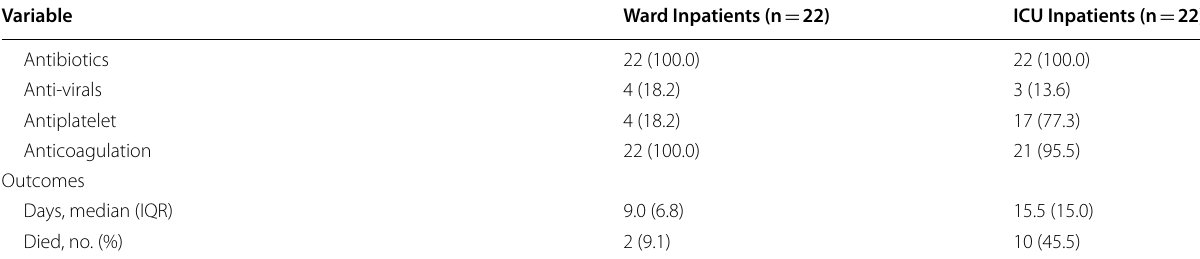
of five proteins (CXCL5, AP3S2, MAX, PDLIM7, FRZB) was determined from the 119 relevant proteins. A t-SNE plot based on the five optimal biomarkers showcases